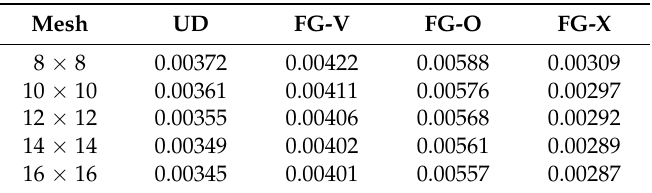
Table 7. Convergence of non-dimensional maximum deflection of CNT-reinforced functionally graded clamped rhombic